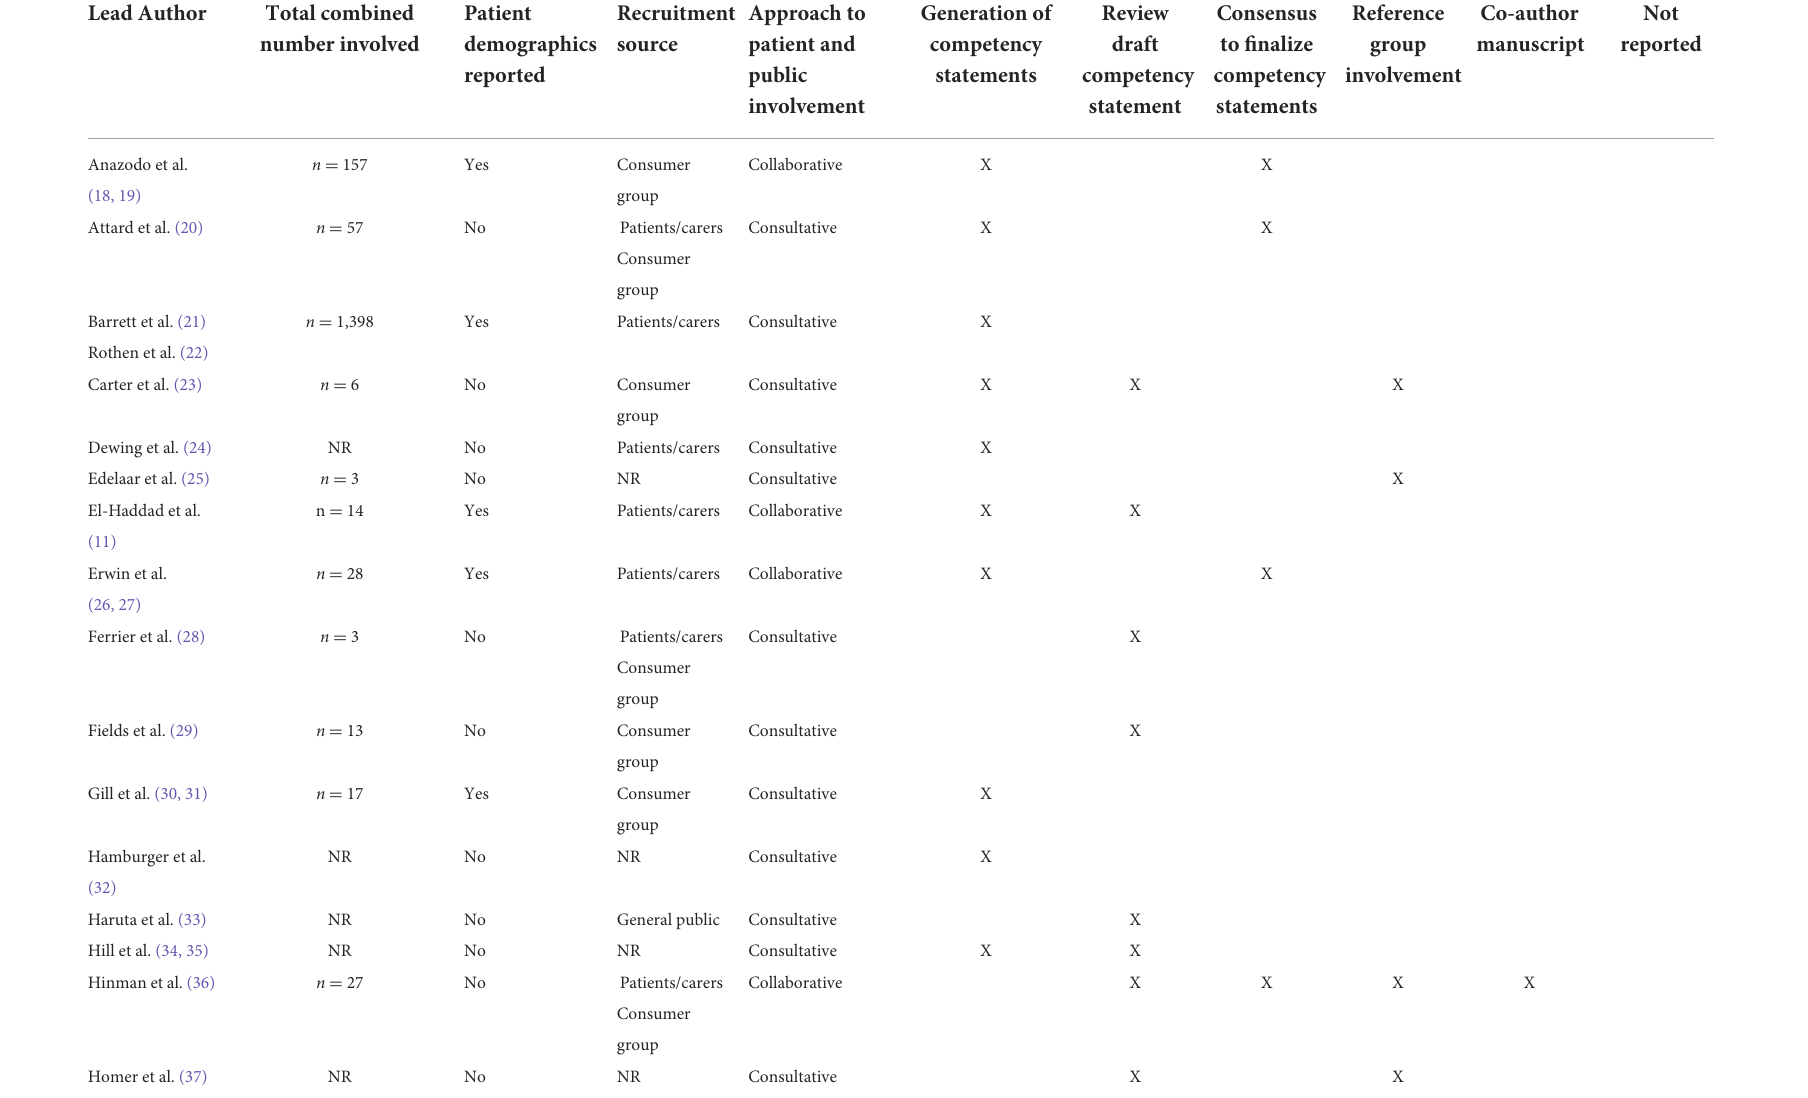
TABLE 3 Summary of patient and public involvement in development of